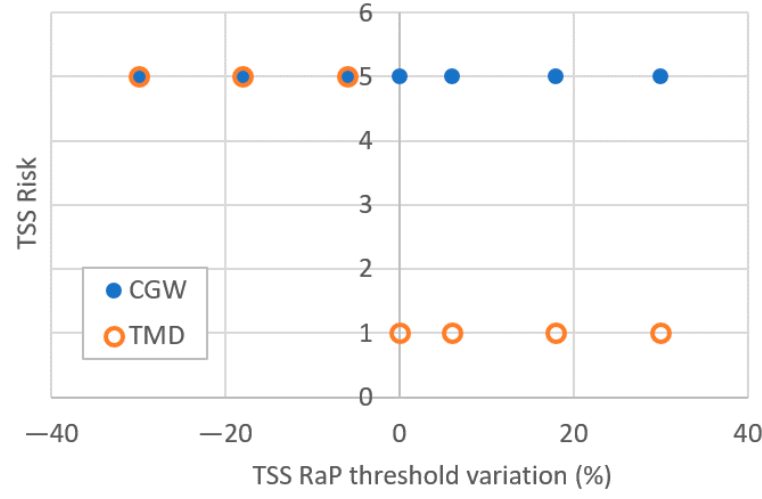
Figure 9. Influence of varying water treatment plant TSS risk thresholds on TSS risk level for the selected portfolio of interventions.